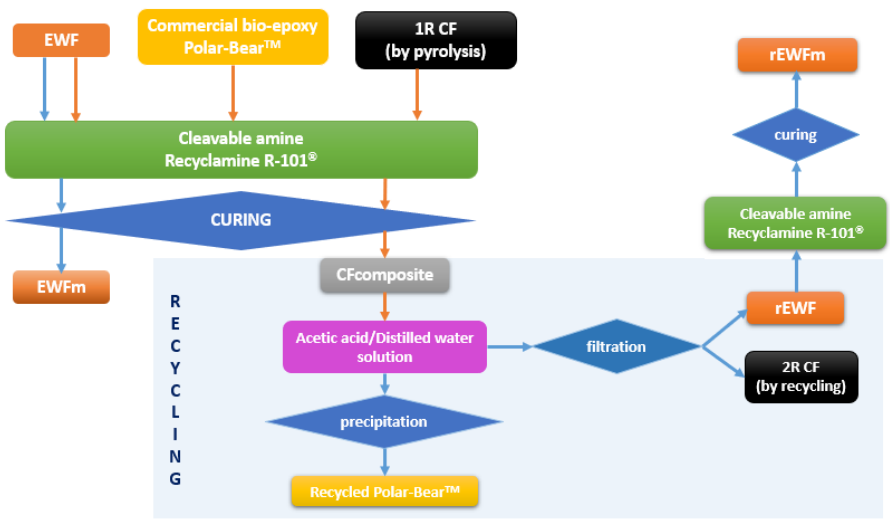
Figure 1 . Block-flow diagram of the recycling process . Figure 1. Block-flow diagram of the recycling process.